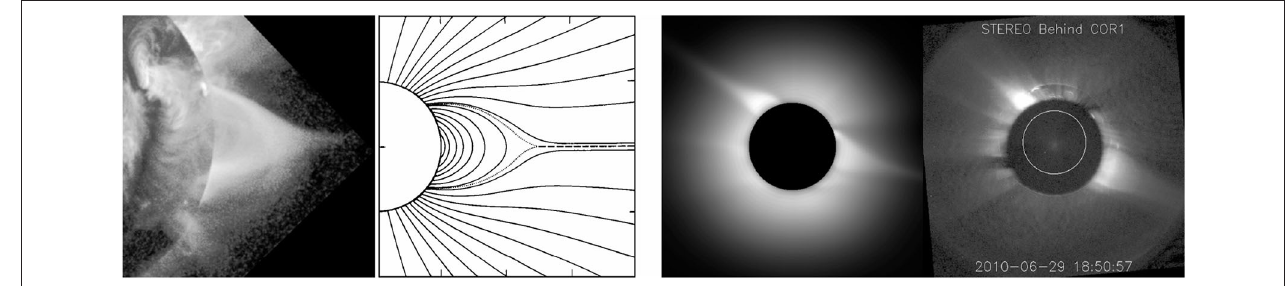
FIGURE 13 | From left to right: A streamer observed with Yohkoh; a schematic drawing of the corresponding magnetic configuration; computed intensity of the corona based on the MAS code; the corresponding image of the COR1 coronograph aboard STEREO-B, on June 29, 2010. From http://www.predsci.com/stereo/home.php.